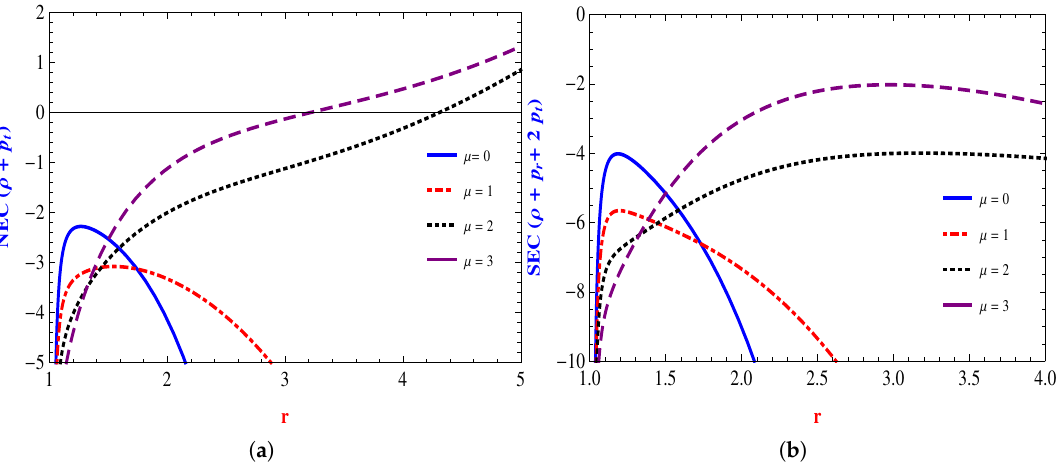
Figure 11. Plots: ( a ) Tangential NEC ( ρ + p t ) and ( b ) SEC ( ρ + p r + 2 p t ) with throat radius r 0 = 1 and α = − 0.1 in f ( Q ) = Q + α gravity. Q